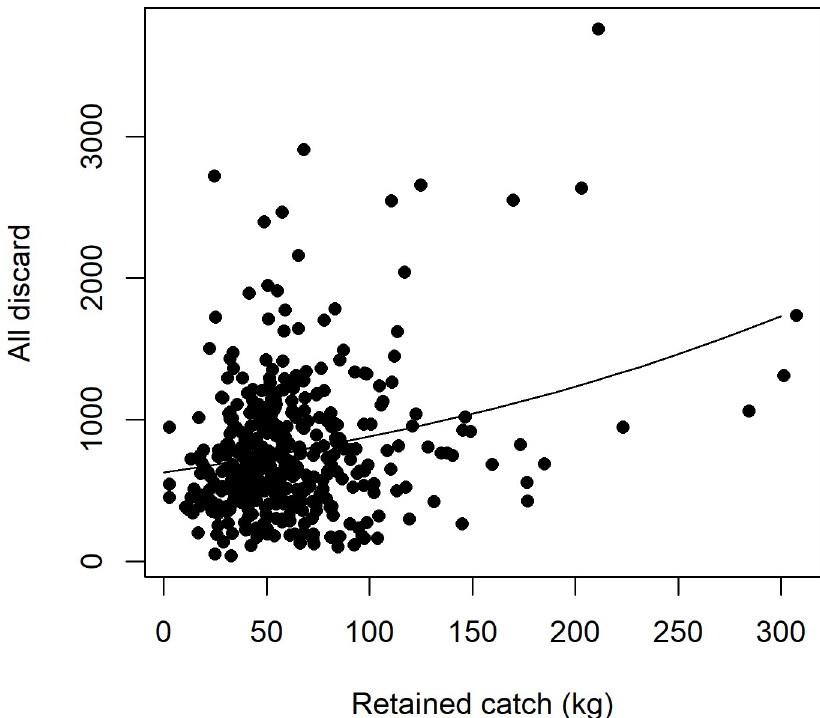
https://doi.org/10.1371/journal.pone.0264055.g008